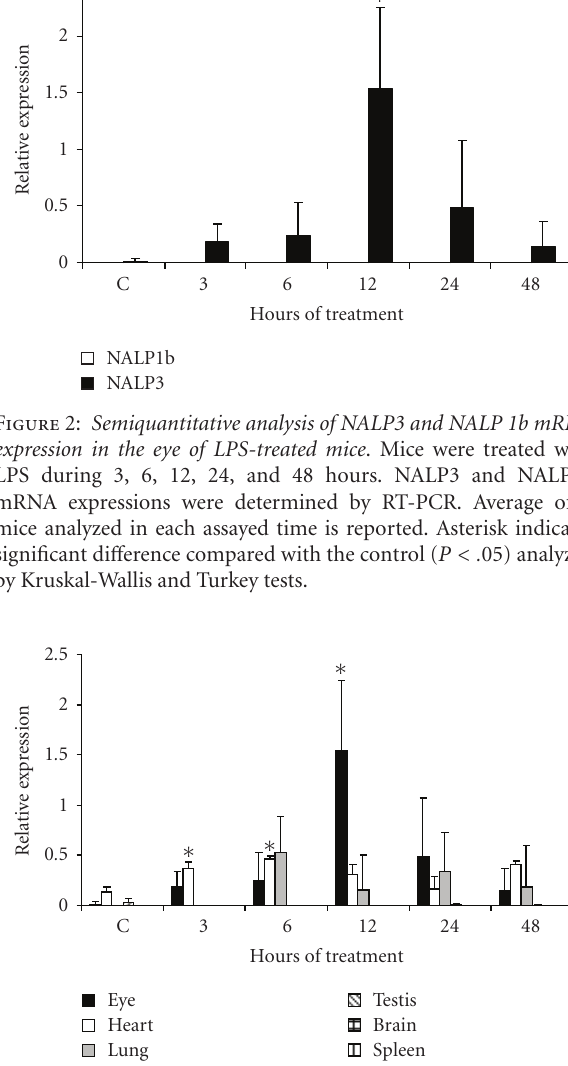
Figure 3: Semiquantitative analysis of NALP3 mRNA expression in the eye, heart, lung, testis, brain, and spleen of LPS-treated mice . NALP3 mRNA expression was determined by RT-PCR in the organs of mice treated with LPS during 3, 6, 12, 24, and 48 hours. Average of 5 mice analyzed in each assayed time is reported. Asterisk indicates significant di ff erence compared with control ( P < . 05) analyzed by Kruskal-Wallis and Turkey tests.